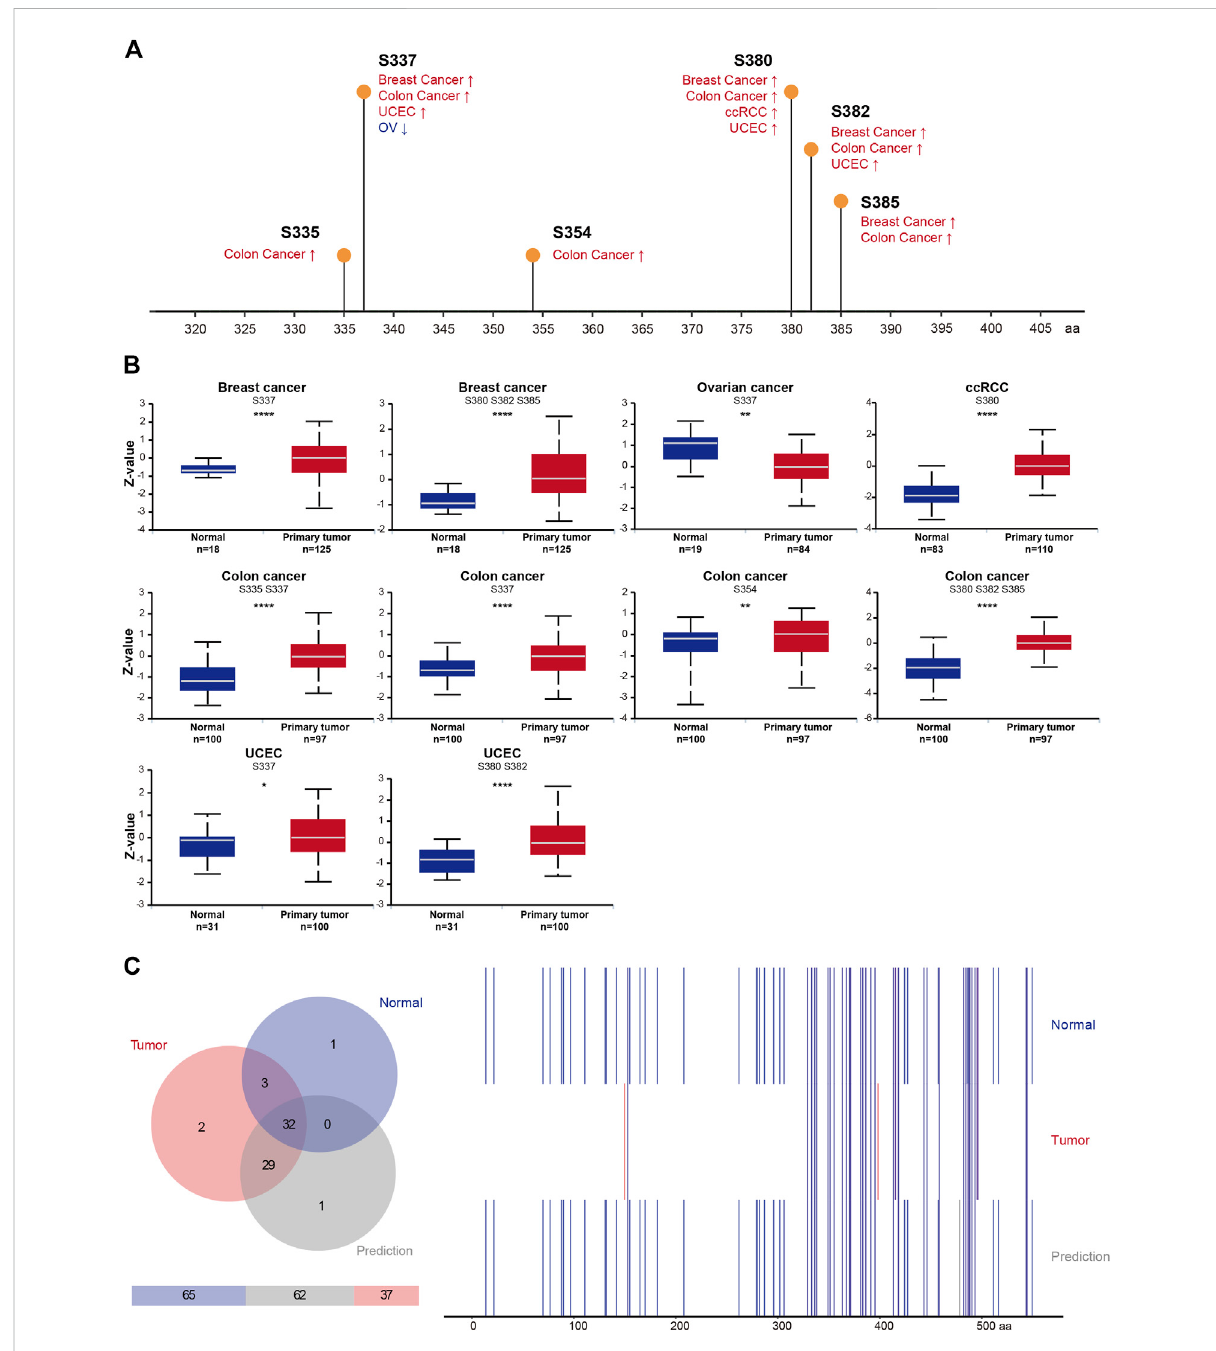
PhosphorylationfeatureofRIOK2indifferenttumorsofTCGA. (A) AnoverviewofthechangesinRIOK2phosphorylationinbreastcancer,colon cancer, ccRCC, UCEC, and OV from the CPTAC database. (B) Box plots representing the RIOK2 phosphorylation level calculated by Z-value (y-axis) for each TCGA cancer type and corresponding healthy groups (x-axis). The statistical signi fi cance computed by Student ’ s t-test is annotated by the number of stars (* p < 0.05, ** p < 0.01, *** p < 0.001, **** p < 0.0001). (C) The Venn diagram on the left counts the number of RIOK2 phosphorylation sites in cancer and healthy tissues, including experimental data and predicted data. The right panel of the chart depicts the difference between tumor cells, normal cells, and predictive sites of RIOK2 phosphorylation. The information about RIOK2 phosphorylation sites in tumor cells was extracted from 72 samples of the Quanti fi cation of Post-Translational Modi fi cations database, and the phosphorylation sites in healthy cells were obtained from the PhosphoNET, Phosphosite Plus, and Phosida datasets (these data have been veri fi ed by high-throughput proteomics technologies); the predicted phosphorylation sites come from thr PhosphoNET